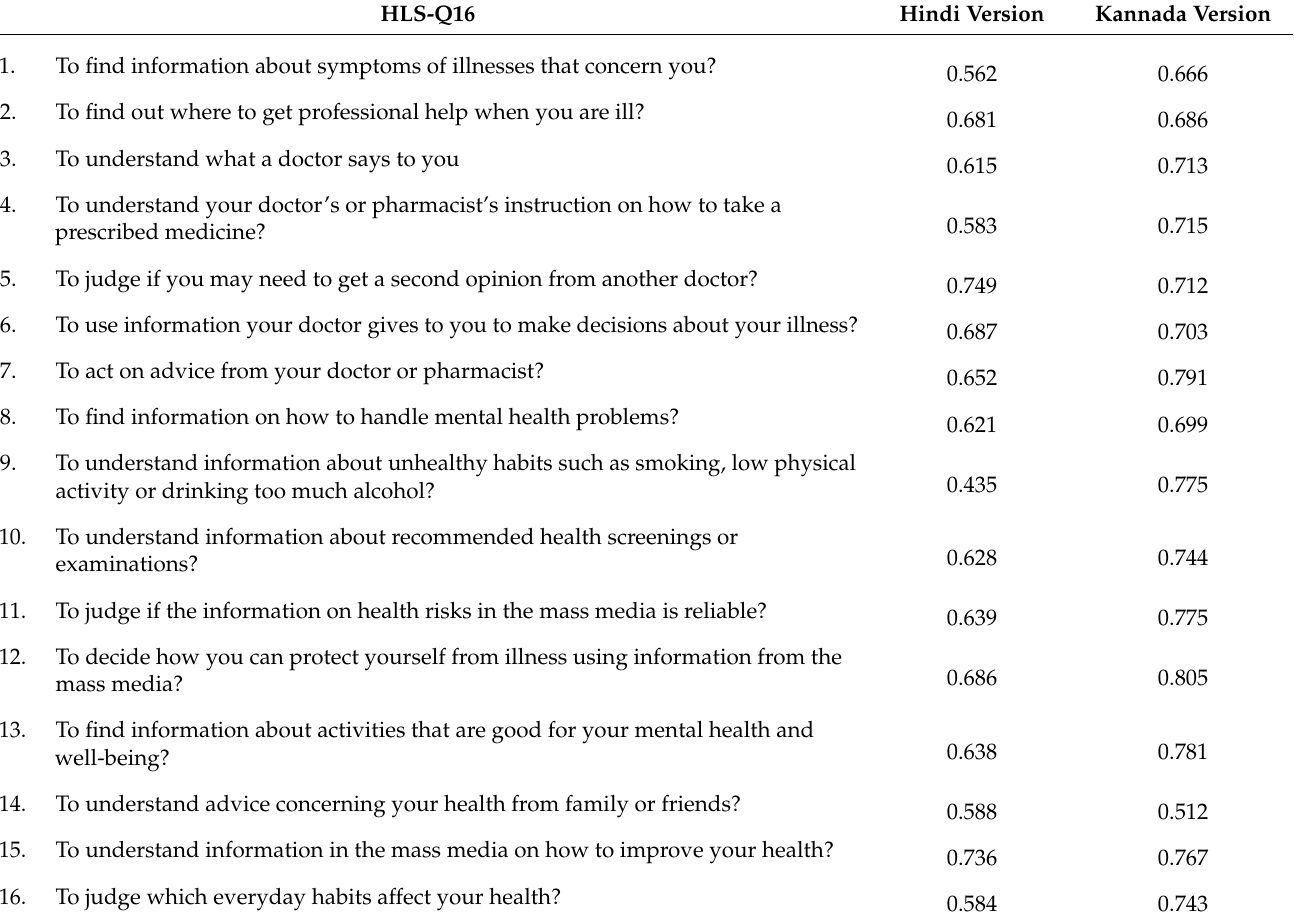
Table 2. Item total correlation co-efficient for the Kannada and Hindi versions of the HLS-EI-Q16.